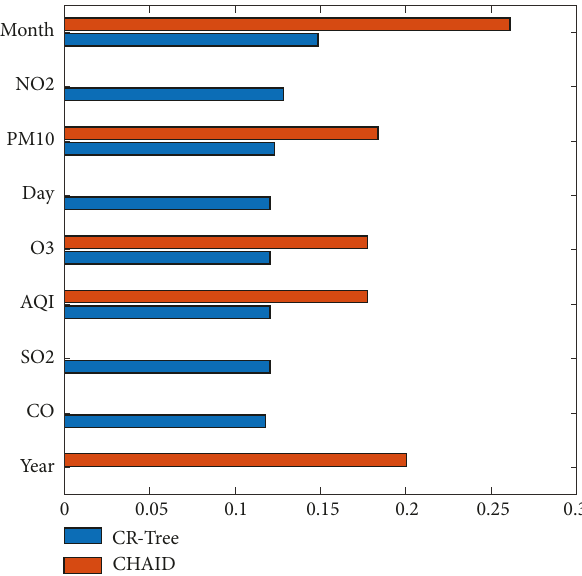
Figure 5: The importance variable for CHAID and CR-Tree